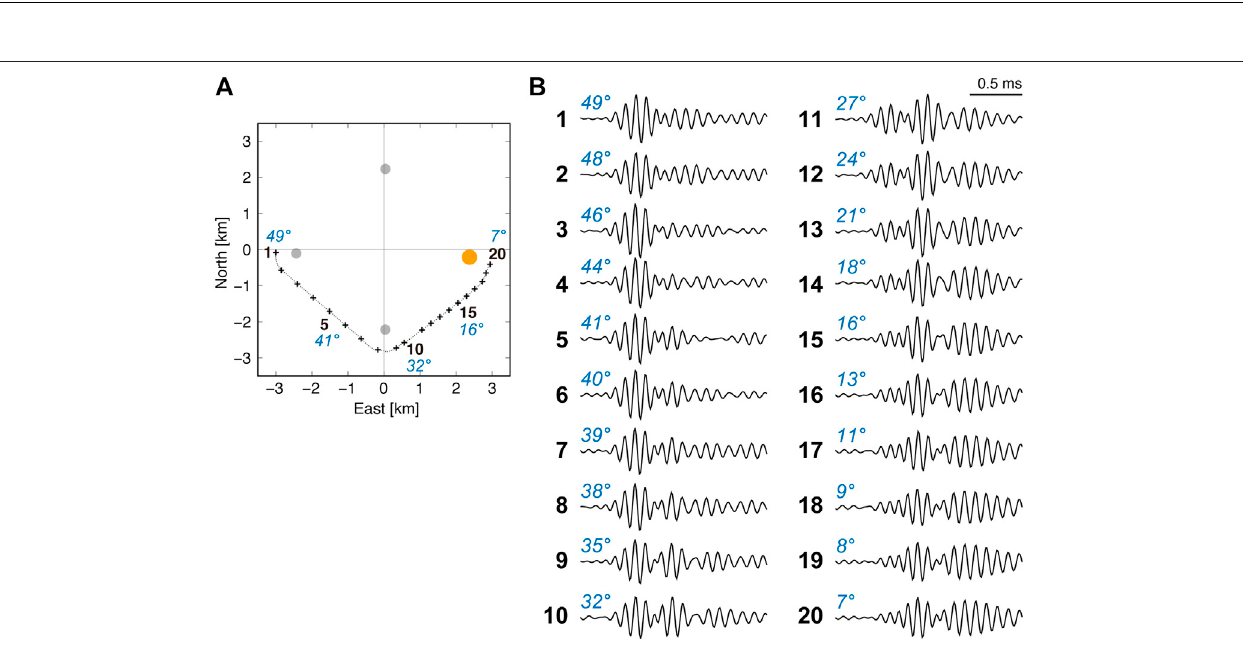
Frontiers in Earth Science |